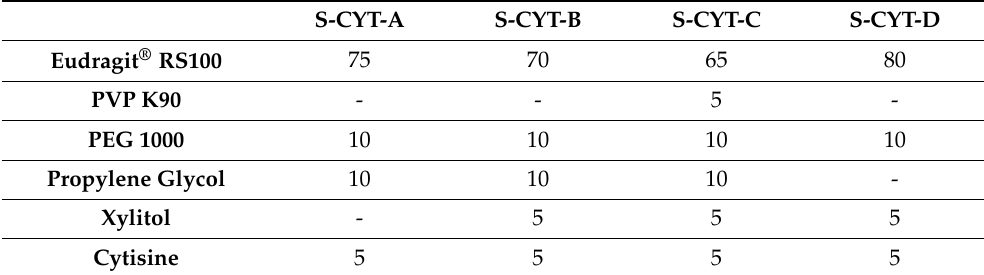
Table 1. Percentage composition ( w / w ) of CYT-loaded matrices prepared by a spray-drying technique. S-CYT-A S-CYT-B S-CYT-C S-CYT-D Eudragit ® RS100 75 70 PVP K90 Propylene